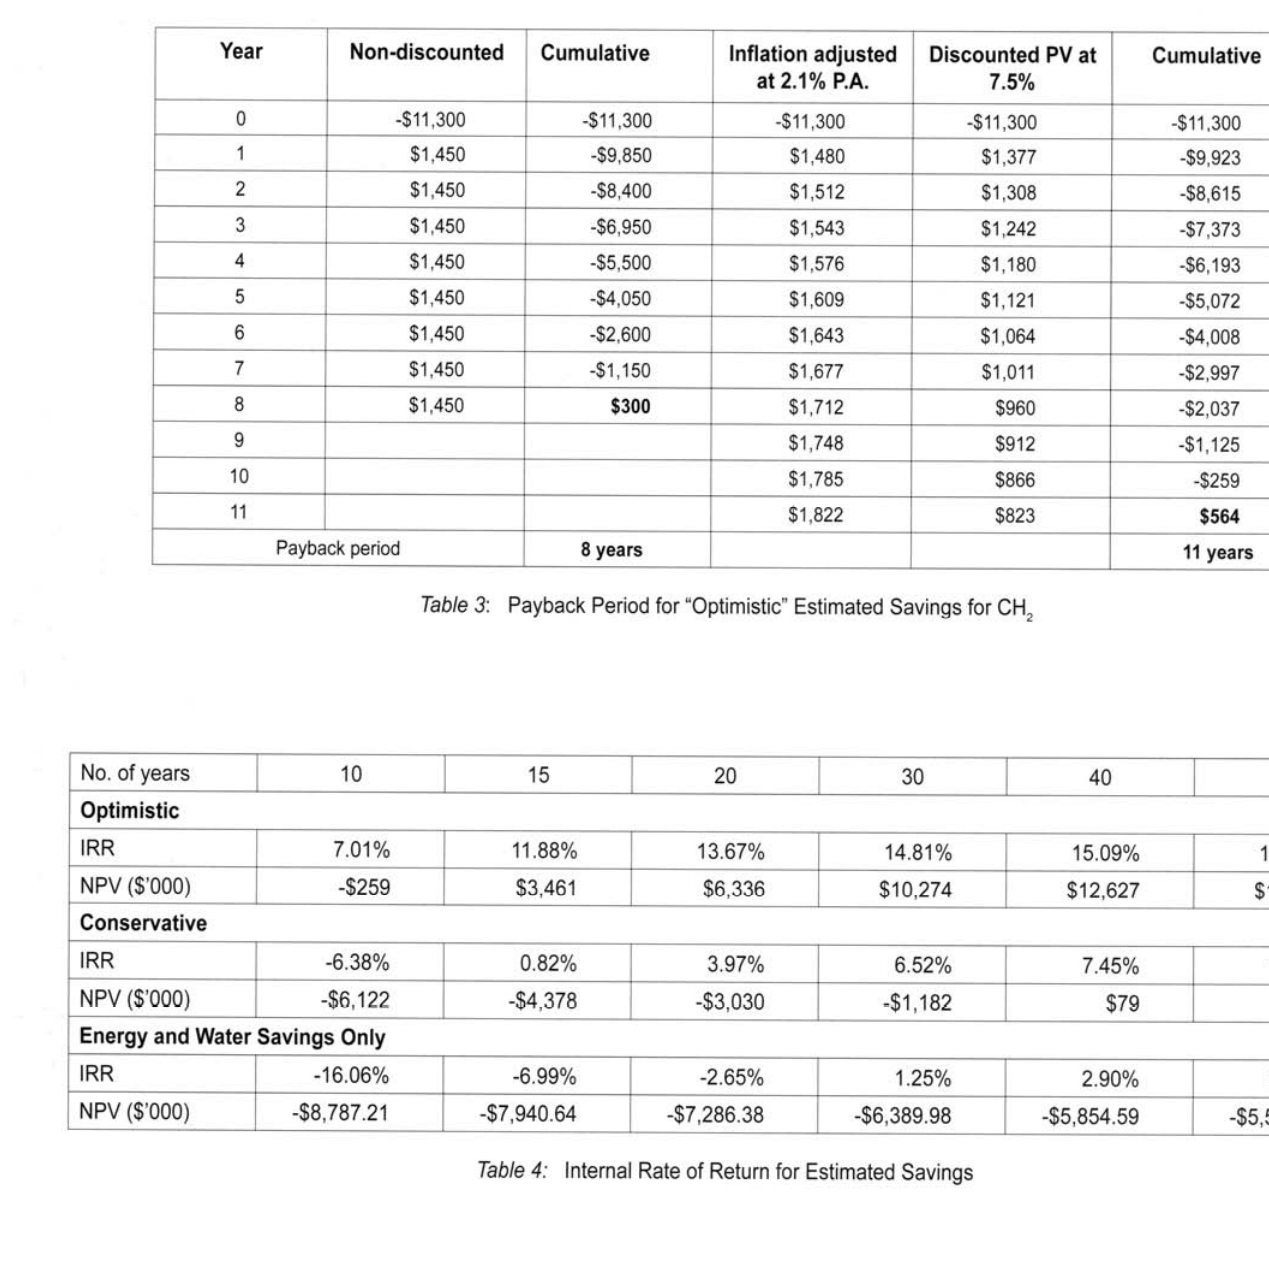
Table 3: Payback Period for "Optimistic" Estimated Savings for CH